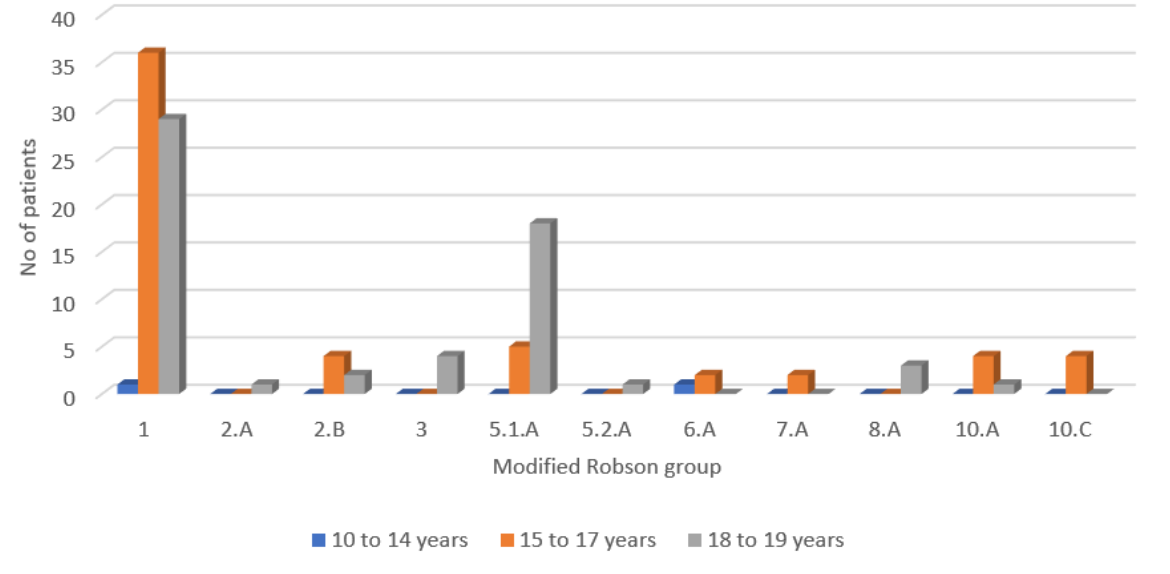
Figure 1. Modified TGCS distribution among age groups.